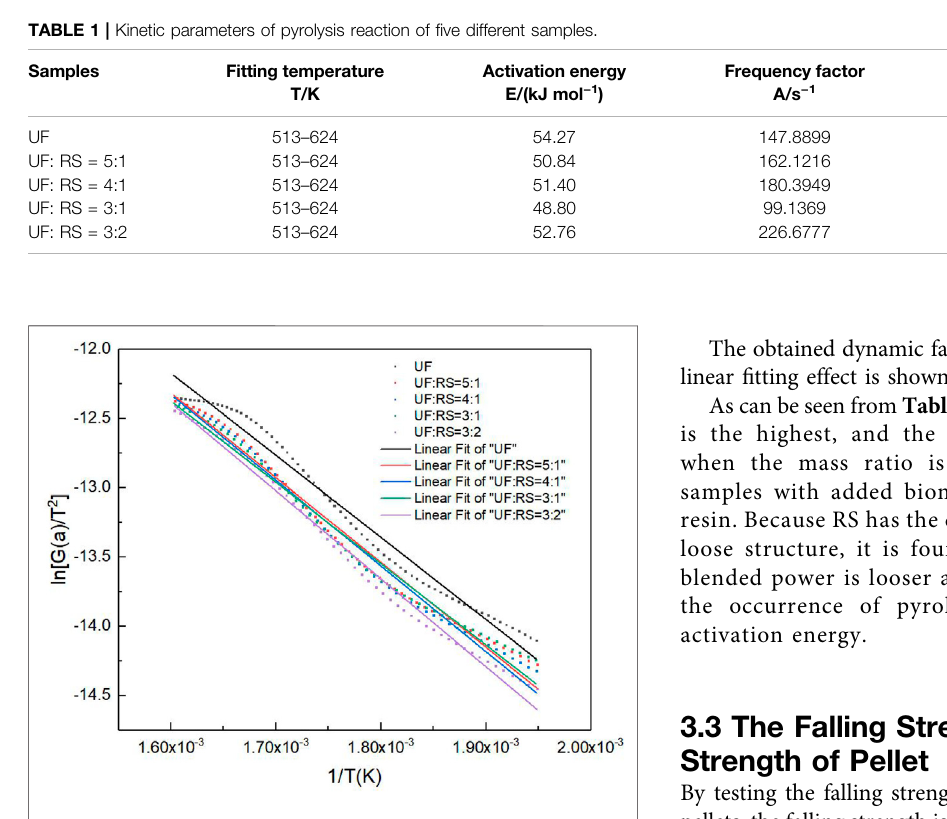
FIGURE 3 | Linear fi tting effect of fi ve different